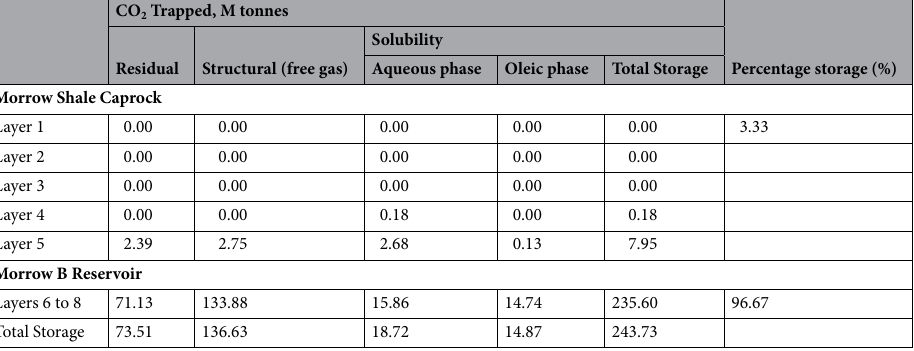
Table 5. CO 2 trapped in reservoir and caprock after 1000 years of monitoring with baseline BHP forecasting strategy.